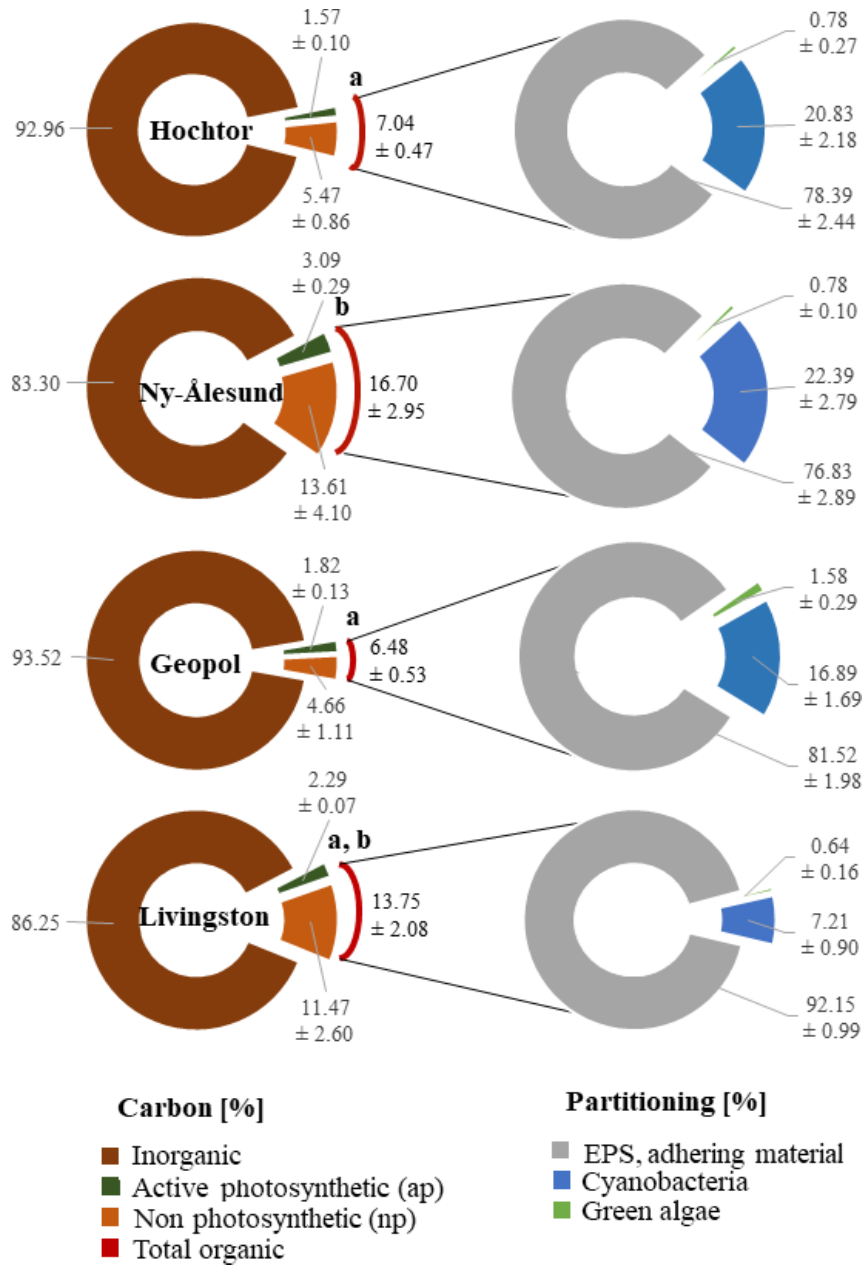
Figure 5. Carbon and BSC group partitioning. Carbon content determined by loss on ignition and CLSM–IA of the 3-D biomaps is combined in percent and applied to the volume of 1cm 3 (left circle). Total organic C obtained by loss on ignition from Hochtor and Geopol differ significantly from Ny-Ålesund ( p ≤ 0.05). Lower-case letters mark statistically significant differences. Area partitioning of cyanobacteria, green algae and adhering material within the BSC is expressed in percentage and is applied to the total area of the 2-D biomaps (right circle). Values are the mean ± standard